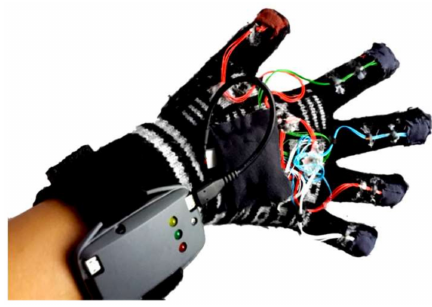
Figure 23. Six sensor-type 3-axis ACC mounted on a data glove for gesture recognition